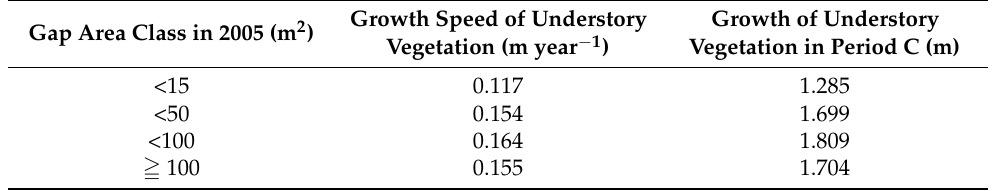
Table 5. Growth of understory vegetation.